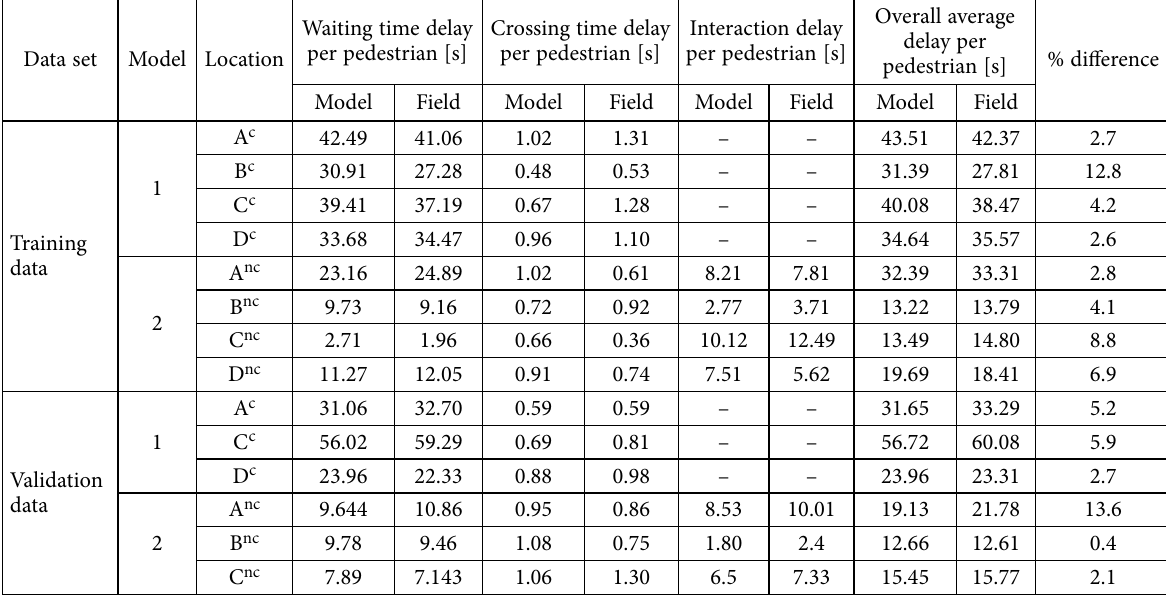
Table 4. Comparison of proposed models values with field data